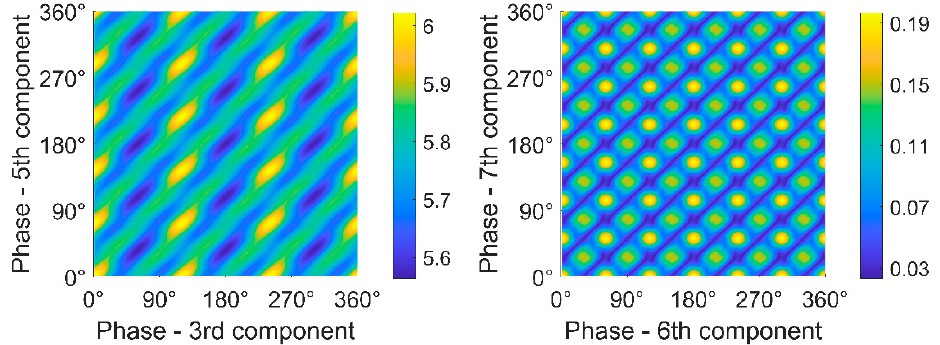
Figure 10. The effect of the roundness component phase on the BSV in a profile including two components.